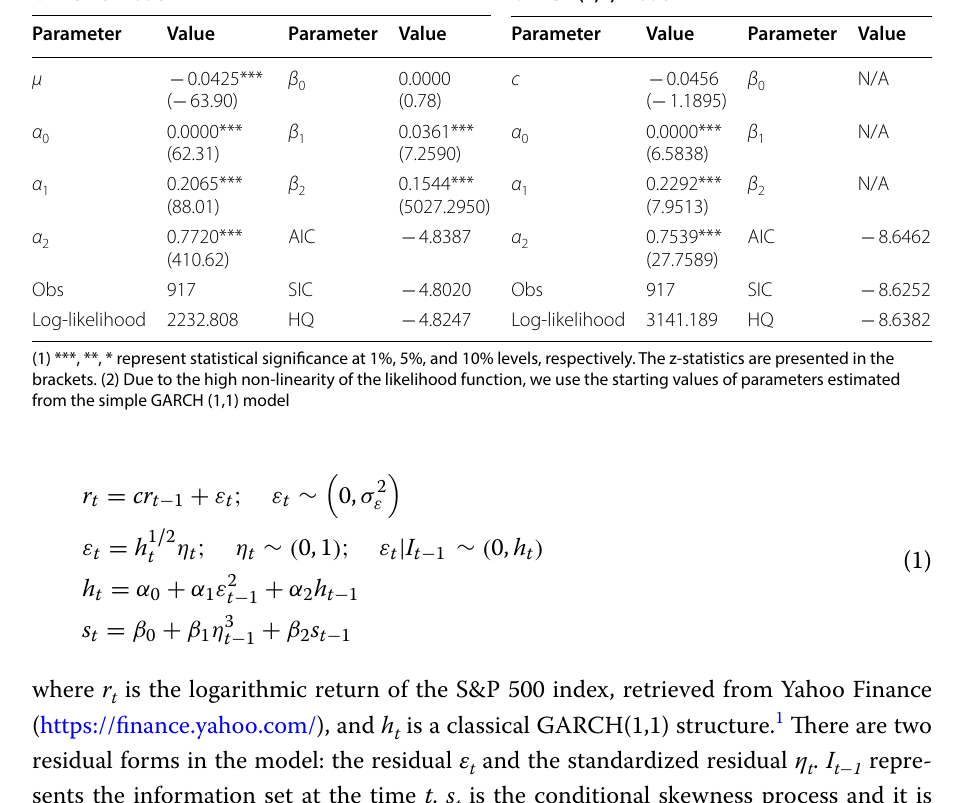
Table 1 Estimation results of GARCH‑S model and GARCH (1,1) model